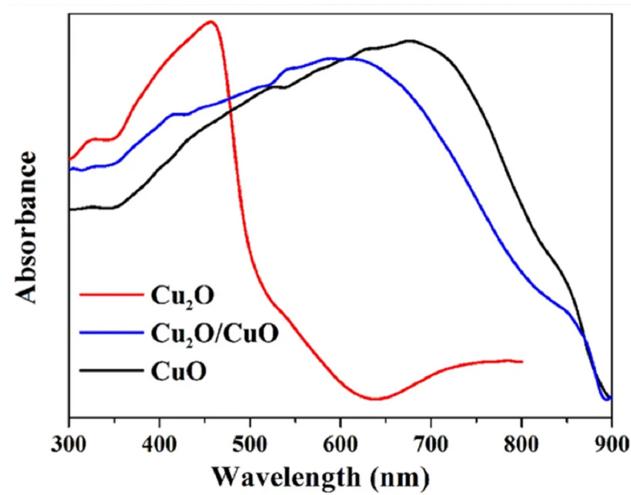
Figure 4. UV–vis diffuse reflectance spectra of the pure Cu 2 O (read line), pure CuO (black line), and Cu 2 O/CuO (blue line) composite films prepared on FTO substrates. Reprinted from [18], with the permission of Springer Nature.